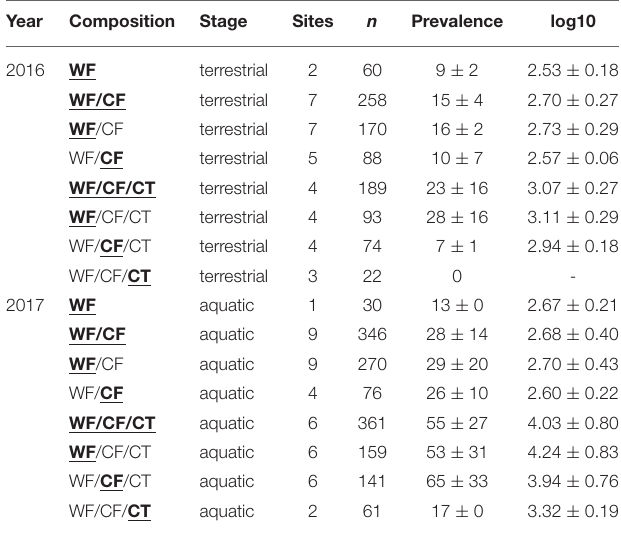
TABLE 4 | Amphibian communities sampled in Alberta and the Northwest Territories in 2016 and 2017, with respective life-stage, number of sampling sites, sampled individuals (n), ranavirus prevalence (% + / − SD) and viral